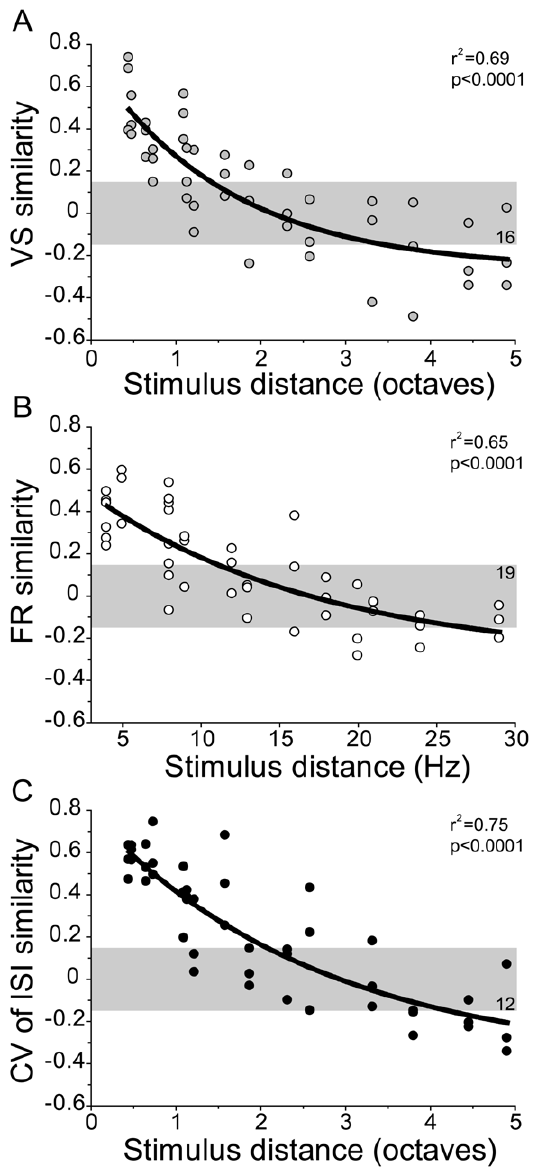
Figure 5. Map similarity for repetition rate differences. (A) Spatial cross-correlation values of raw VS values generated by repetition rates between 1 and 30Hz (see Fig. S4A) and plotted as a function of the logarithmic repetition rate difference for all three hemispheres. The solid line is a logarithmic fit. The gray area indicates non-significant correlation values ( n =16/45). (B) Cross-correlation values of raw FR generated by repetition rates between 1 and 30Hz (see Fig. S4B) and plotted as a function of the linear repetition rate difference. Non- significant correlations: n =19/45. (C) Cross-correlation values of CV of ISI generated by repetition rates between 1 and 30Hz (see Fig. S4C) and plotted as a function of the logarithmic repetition rate difference. Non- significant correlations: n =12/45.